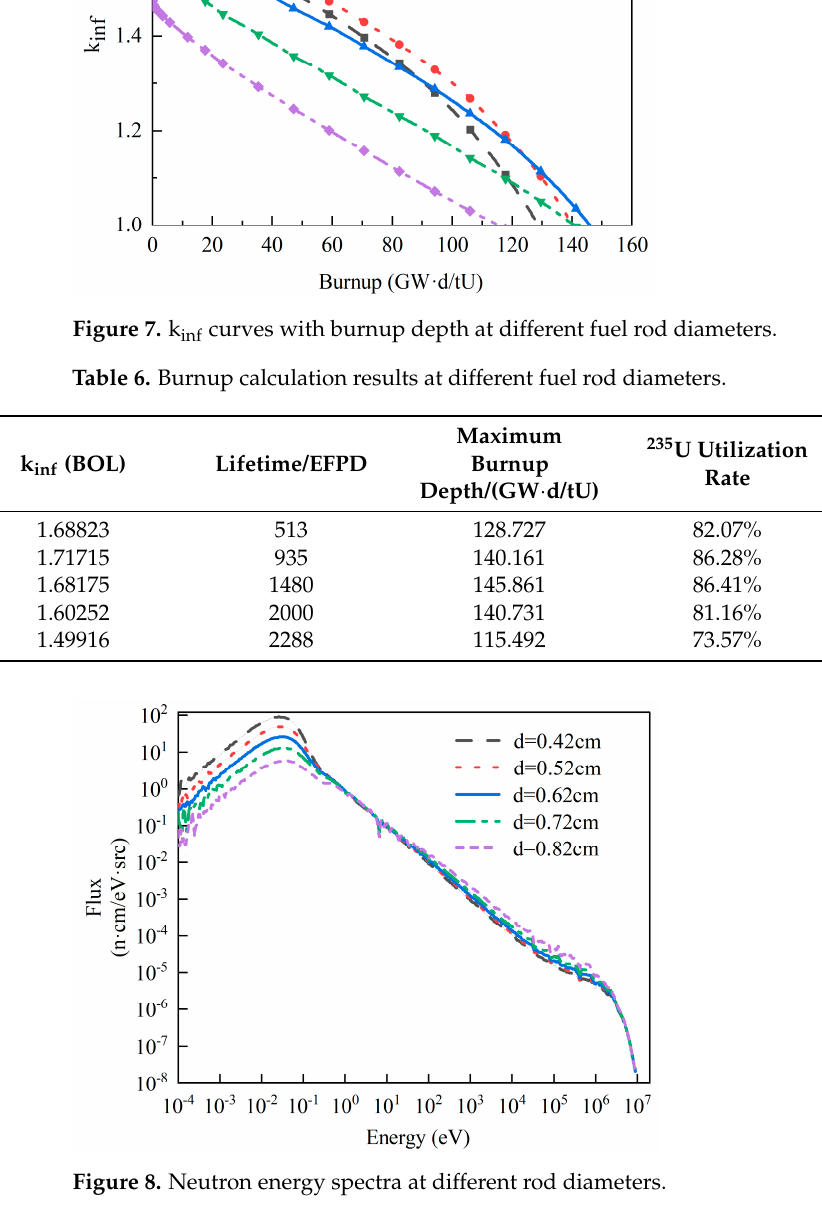
Figure 7. k inf curves with burnup depth at different fuel rod diameters. Table 6. Burnup calculation results at different fuel rod diameters.